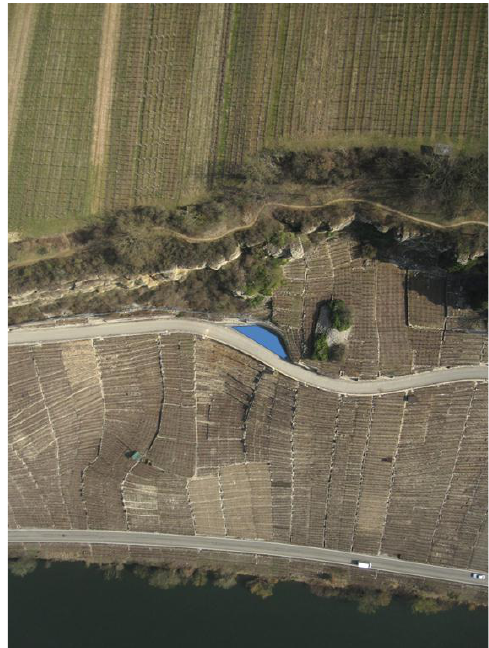
Figure 6: Exemplary UAV image. Figure 6. The captured area features a terrain undulation of about 100m, thus the flying height varies between 219m above ground for the valley floor and 125m above ground for the summit area. The flying height with respect to the area marked in blue is 166m, which results in a GSD of 4.3cm. The image footprint is approximately is 128mx170m.